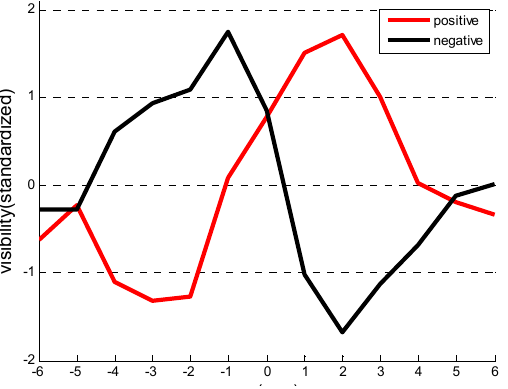
Figure 11. Average standardized visibility anomalies in Northern China around the peak phase of the EU pattern from a lag of − 6 days to a lag of 6 days. The red line is the positive phase and the black line is the negative phase.